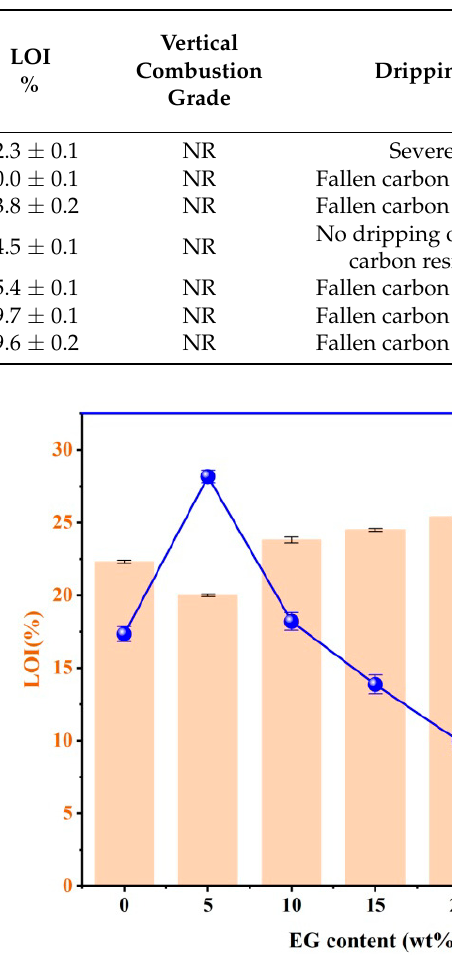
Figure 6. LOI and tensile strength of MPUE/EG at different EG contents .